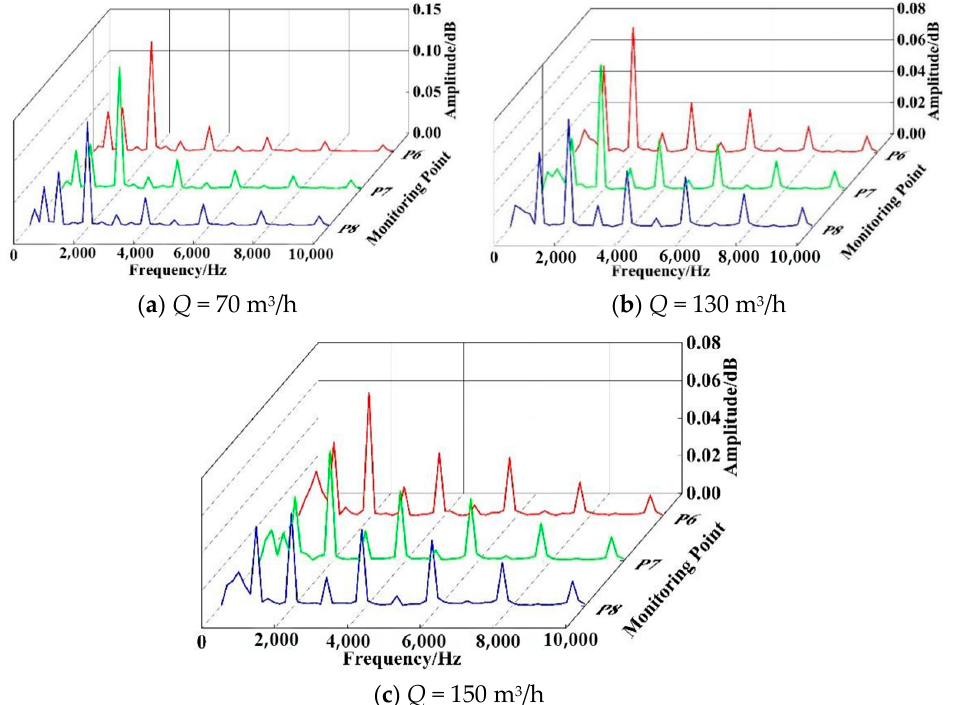
Figure 12. Frequency domain diagram of pressure fluctuations at monitoring points P6, P7, and P8.